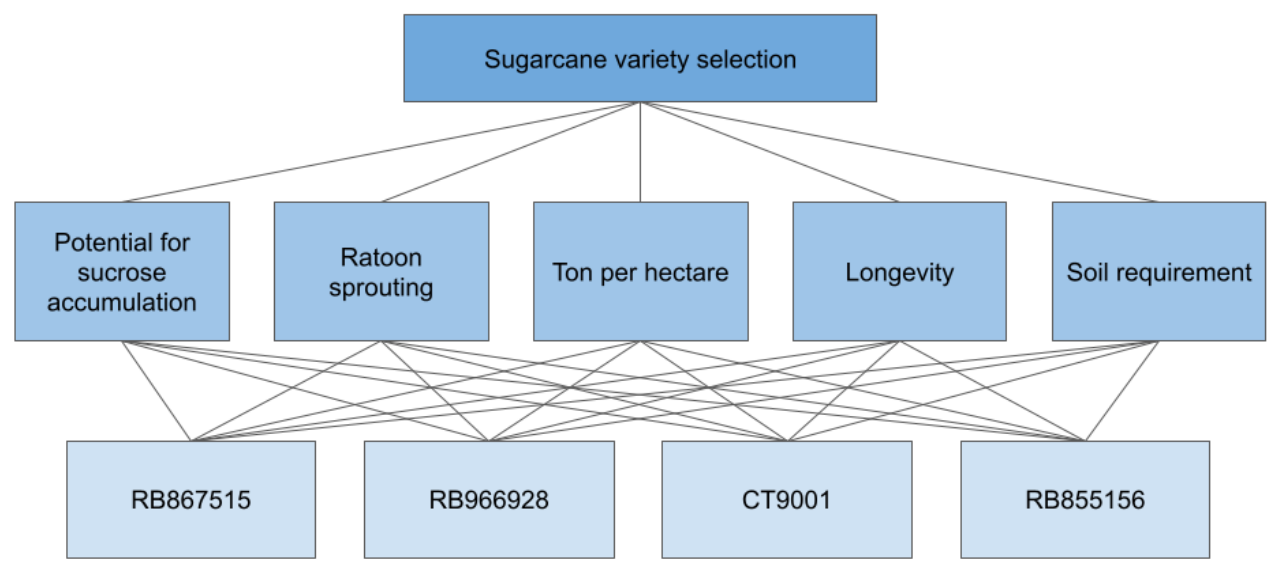
Figure 3. Representation of the basic hierarchical structure of sugarcane used in this research.